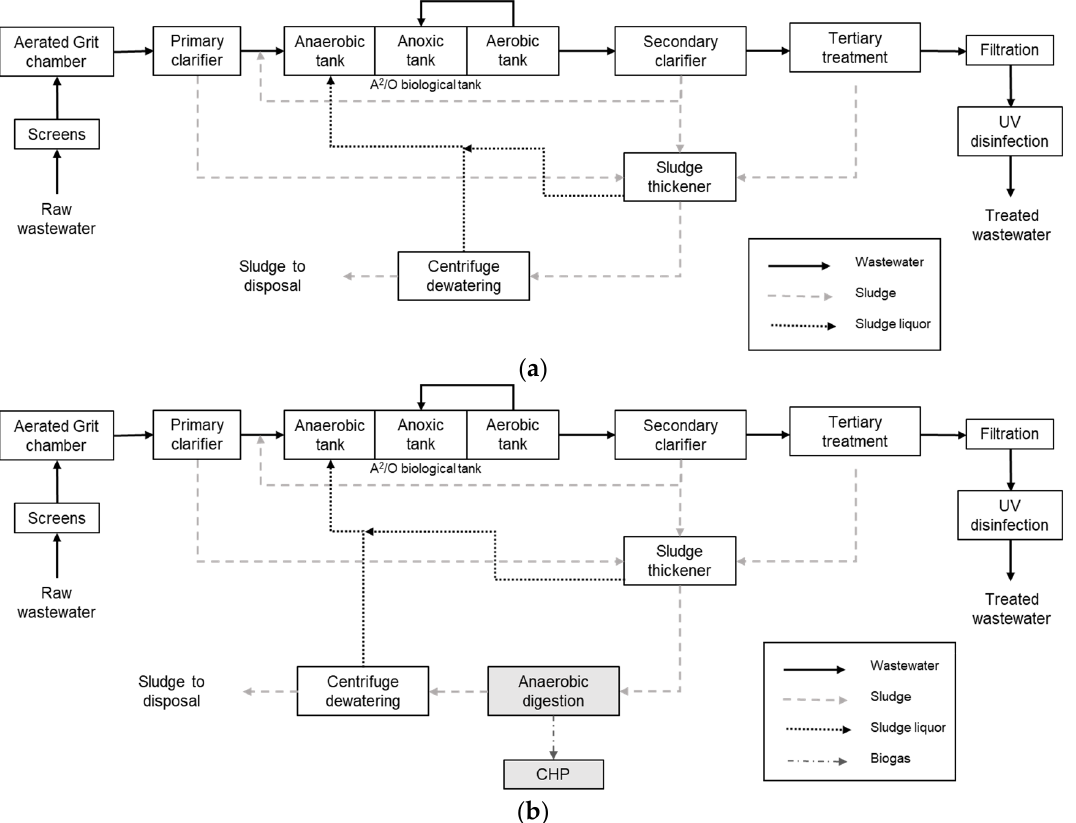
Figure 1. Plant scheme ( a ) Original WWTP Scheme; ( b ) Modified scheme of the WWTP with an AnSS stage and CHP highlighted in grey.